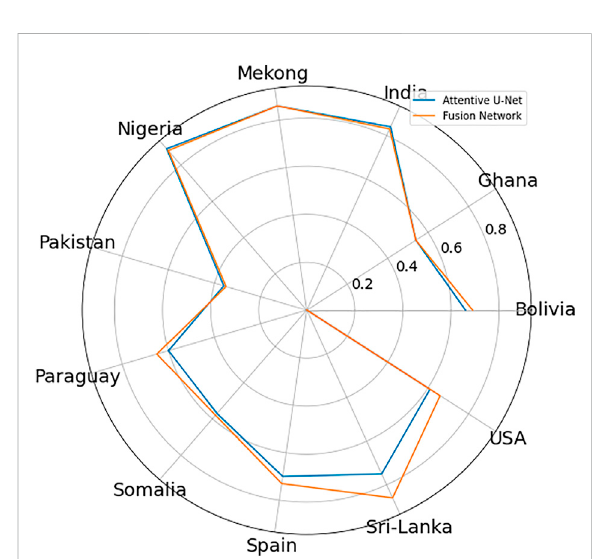
FIGURE 8 Spider Graph: Graphical IoU comparison of our two proposed fl ood detection methods “ Attentive U-Net ” and “ Fusion Network ” on each